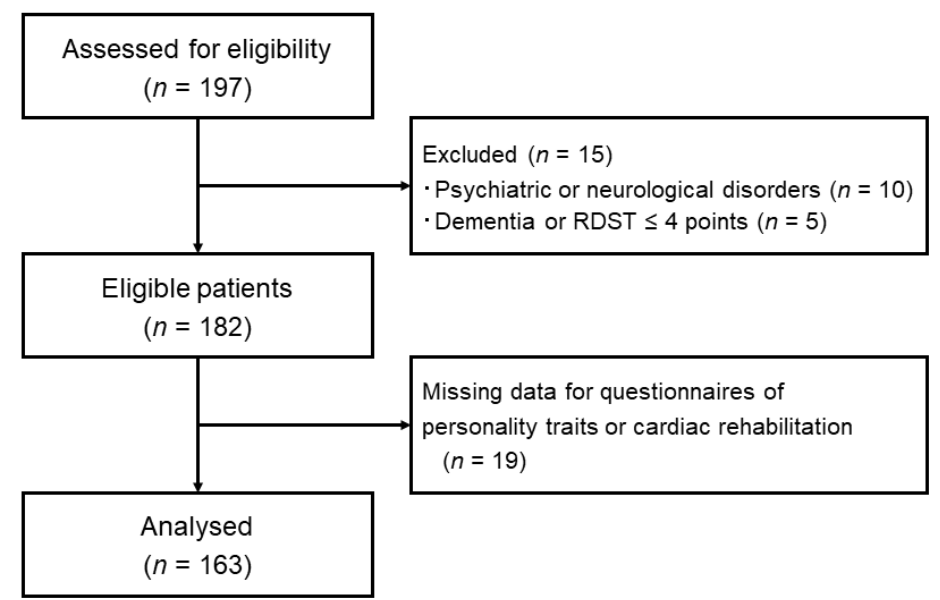
Figure 1. Flowchart of patient selection. RDST, Rapid Dementia Screening Test. Table 1. Characteristics of the study participants.